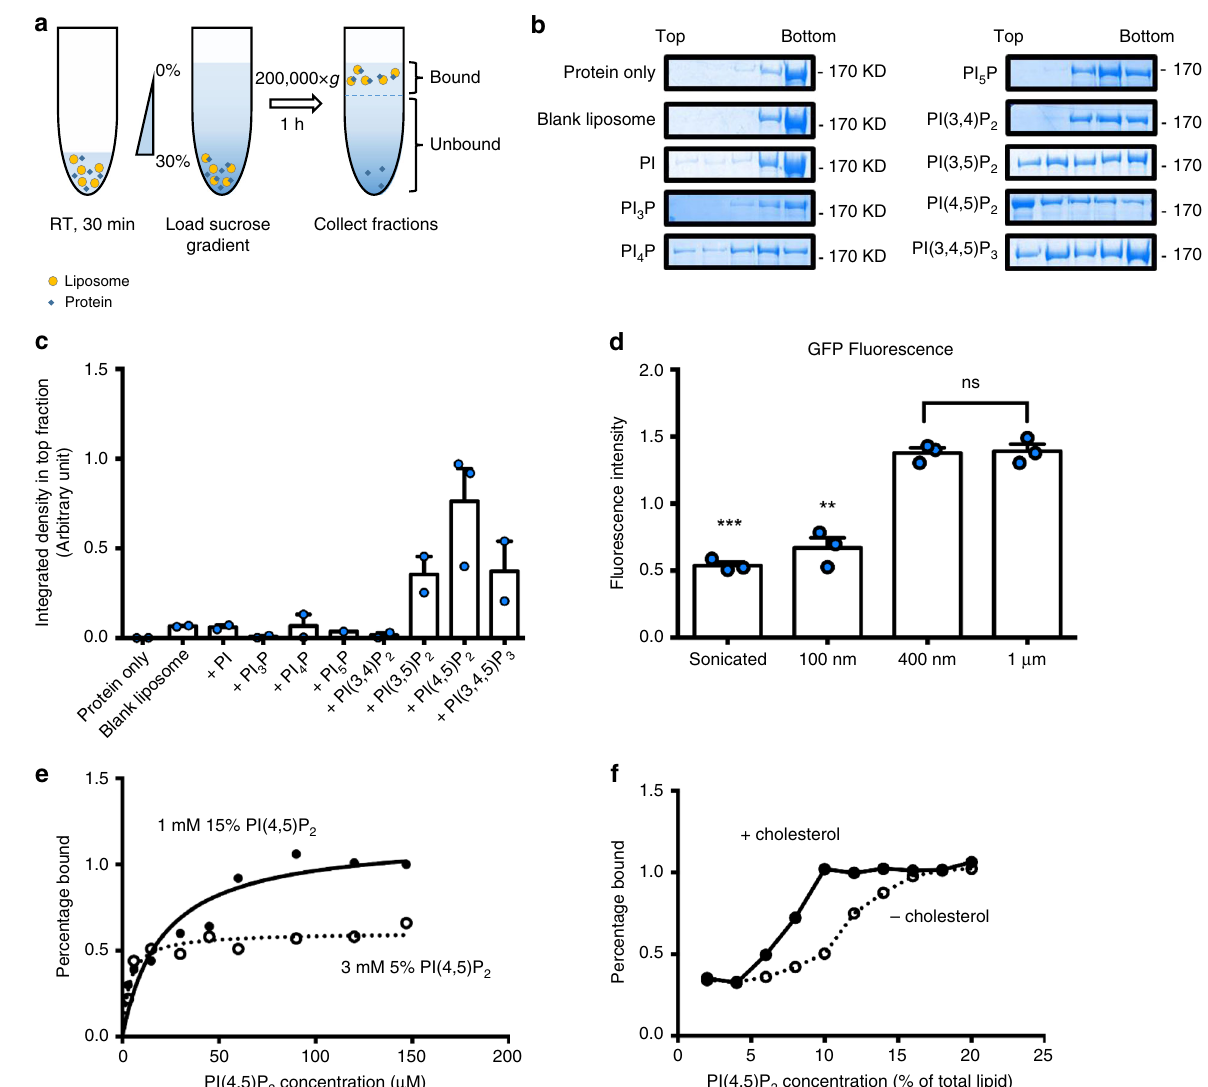
Fig. 5 WHAMM binds to PI(4,5)P 2 in vitro. a A schematic representation of the liposome fl otation assay. b Puri fi ed full-length WHAMM was incubated with DOPC-DOPE blank liposomes or liposomes doped with 15% of different PIPs as indicated, and then applied to the fl otation assay. Each fraction was collected carefully and further analyzed by SDS-PAGE followed with Coomassie staining. c Band density in the top fraction from b and repeat experiments was measured using ImageJ. Each experiment was repeated two times except for PI 5 P (once) and PI(4,5)P 2 (three times). Error bars indicate SEM. d GFP- tagged WHAMM was incubated with different sized liposomes containing 15% PI(4,5)P 2 and then applied to the fl otation assay. The top fraction was collected and monitored by a fl uorescence spectrophotometer to detect the GFP- fl uorescence intensity. n = 3 independent experiments. Error bars indicate SEM. Two-tailed t -test; *** p < 0.001; ** p < 0.01; ns, not signi fi cant. e Full-length WHAMM was incubated with liposomes containing a constant concentration of PI(4,5)P 2 but varying in density. The mixture was centrifuged down and the liposome pellet was subjected to SDS-PAGE. Band density was measured using ImageJ and normalized with input. f Liposomes containing increasing proportions of PI(4,5)P 2 with or without 10% cholesterol were incubated with full-length WHAMM. The mixture was then centrifuged down and the liposome pellet was subjected to SDS-PAGE. Band density was measured and normalized with input using ImageJ. Source data are provided as a Source Data fi